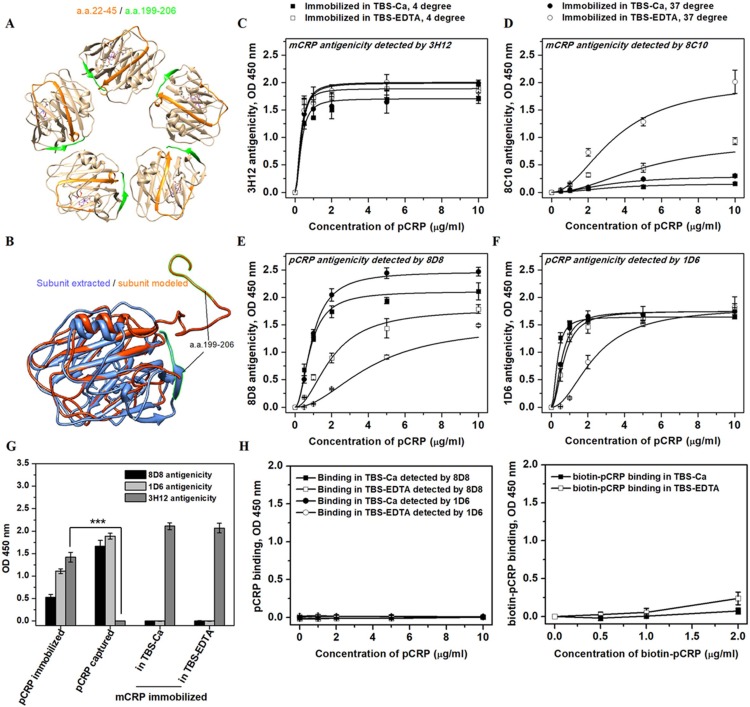
Surface-immobilization of pCRP induced the formation of an intermediate with dual antigenicity.(A) a.a.22-45 (recognized by 8C10; orange) is mostly packed inside the subunit in pCRP (PDB ID: 1B09), while a.a.199-206 (recognized by 3H12; green) lies at the subunit interface of the pentamer. (B) The subunit structures extracted from the crystal structure of pCRP (medium blue; PDB ID: 1B09) or de novo modeled by I-TASSER (orange red; C-Score = -0.78) were superposed. For I-TASSER modeling, templates with a homology over 25% were excluded. a.a.199-206 segment lies on the subunit interface of pCRP and packs closely against the subunit body. By contrast, this segment extrudes from the subunit body in the modeled structure, which is why 3H12 can report the pentamer disassembly. (C-F) Indicated concentrations of pCRP in TBS-Ca or TBS-EDTA (pH 7.4) were added into Nunc MaxiSorp microtiter wells and incubated overnight at 4°C or for 1 h at 37°C. The antigenicity expression of the immobilized protein was assayed with mAbs 3H12 (C), 8C10 (D), 8D8 (E) or 1D6 (F). Immobilized pCRP showed dual antigenicity of both pCRP (8D8 and 1D6) and mCRP (3H12 and 8C10). (G) 5 μg/ml pCRP or mCRP was immobilized in bicarbonate coating buffer (pH 9.6), TBS-Ca or TBS-EDTA (pH 7.4) at 4°C overnight. Alternatively, 2 μg/ml pCRP was captured by immobilized polyclonal sheep anti-human CRP antibody for 1 h at 37°C in TBS-Ca (pH 7.4). The antigenicity of the immobilized or bound antigens were determined by 8D8, 1D6 or 3H12. When mCRP was immobilized, only mCRP antigenicity (3H12) could be detected. By contrast, pCRP bound to immobilized pAb showed only pCRP antigenicity (8D8 and 1D6). However, directly immobilized pCRP showed significant 3H12 antigenicity (***p < 0.001). (H) Binding of unlabeled (the left panel) or biotin-labeled pCRP (the right panel) to mCRP (5 μg/ml) immobilized in TBS-Ca (pH 7.4) overnight at 4°C. The binding status was detected by mAbs and HRP-avidin, respectively. There was no binding of pCRP to the immobilized mCRP, excluding the possibility that the dual antigenicity was contributed by mCRP and survived pCRP. Data were obtained from at least three independent experiments and represented as mean ± SEM. For C-F, values underwent a nonlinear curve fit with OriginPro 8 software, during which the category was set as “Growth/Sigmoidal” and the function was set as “Hill1”.